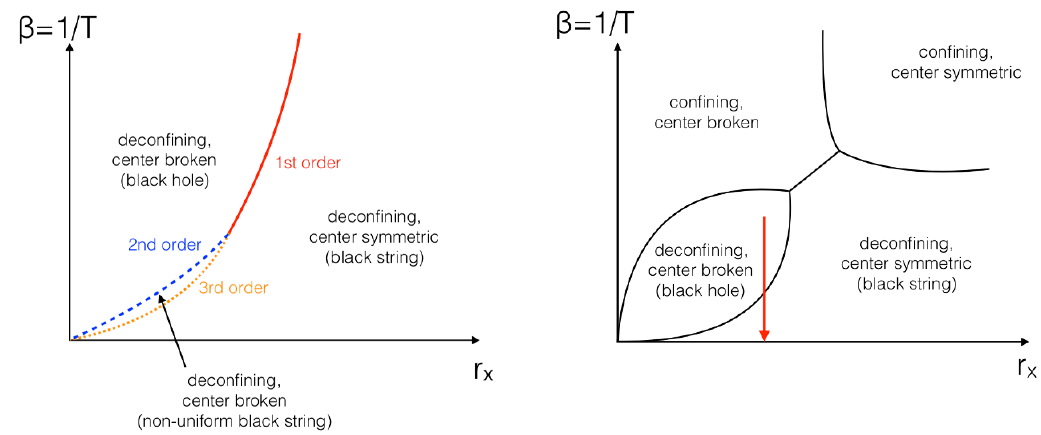
Figure 2 . Conjectured equilibrium phase diagram for the gravity dual to 2d maximal SYM (left) and purely bosonic Yang-Mills with 8 scalars (right) as a function of the length of the spatial ( r x ) and temporal ( (cid:12) , inverse temperature) circles, respectively. The arrow on the r.h.s. panel indicates applicability of numerical simulations in this